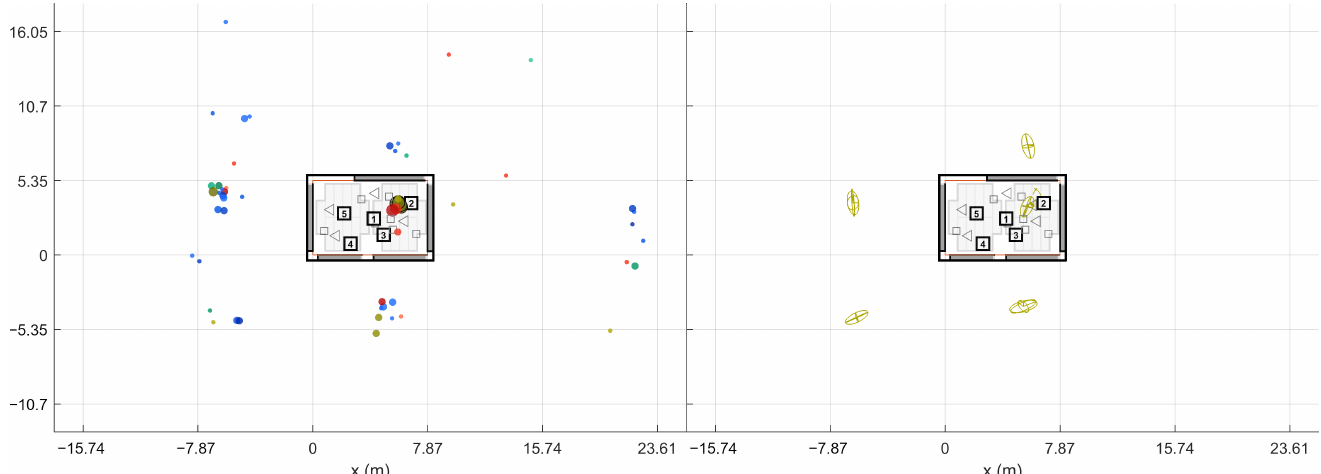
Figure 4. On the left : early reflection (ER) objects from 5 receivers measuring one source in a rectangular room. The detected receiver positions are found to be noisy and not all receivers are detecting the same reflections. On the right : image sources detected from 10 receiver measurements. The algorithm is able to filter out most of the noise and reveal image source positions that are mostly